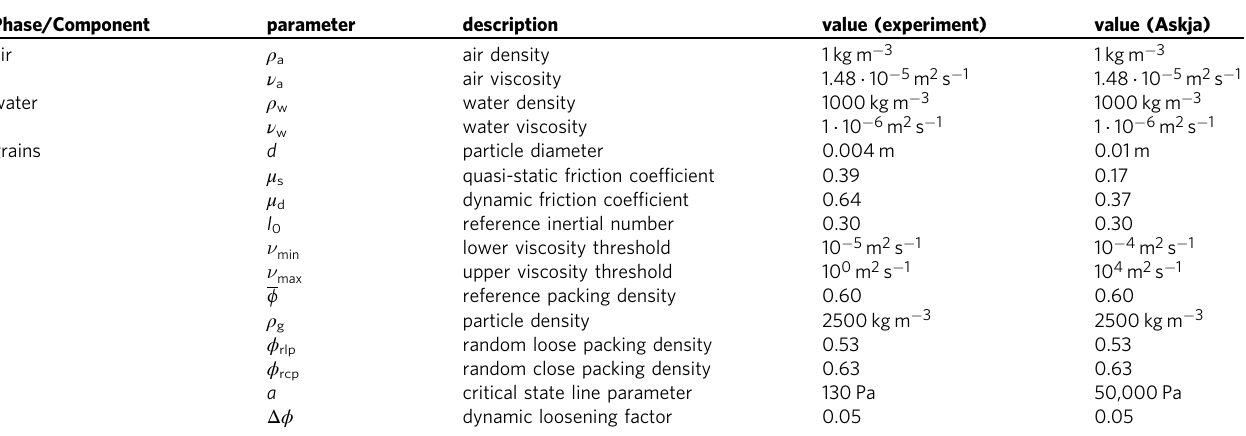
reaches its fi nal run-out after ~1.5 s (Fig. 3j), similar as in the experiment (Fig. 3e), and forms a stable pile. Virtual wave gauges recorded the water surface at selected positions over time. The results are shown and compared with the experimental wave signals in Fig. 4.